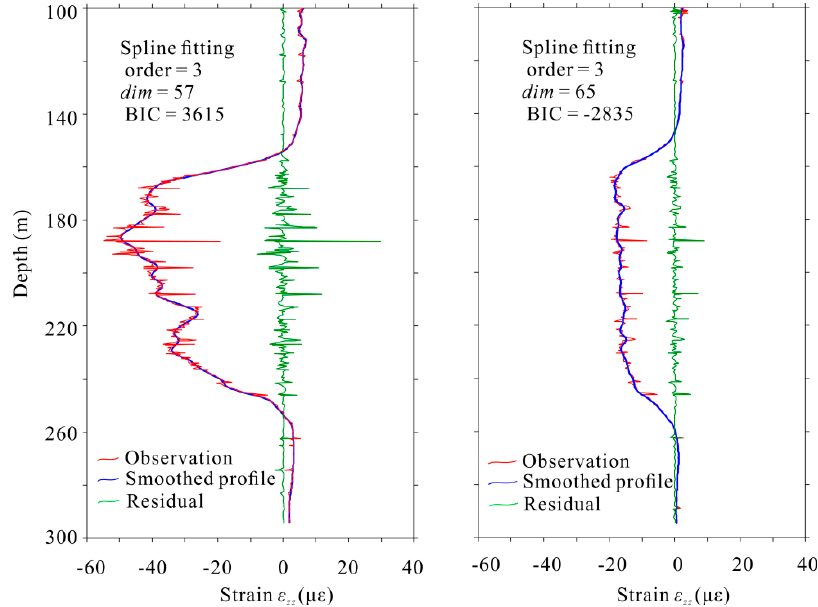
Figure 5. Example of smoothed profiles of strain data obtained using a Bayesian method of spline fitting. The order of the spline functions was fixed at 3, and the dimension was determined by minimizing the Bayesian information criterion